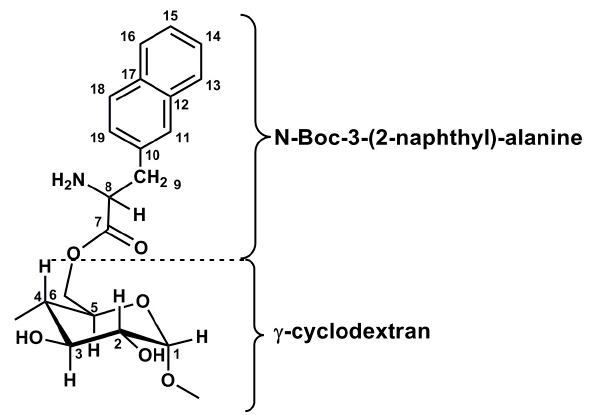
Figure 5. The Molecular structure of the γ -cyclodextran nanocarrier system used against breast cancer cell lines [93]. (Source: Gourevich et al., 2013).